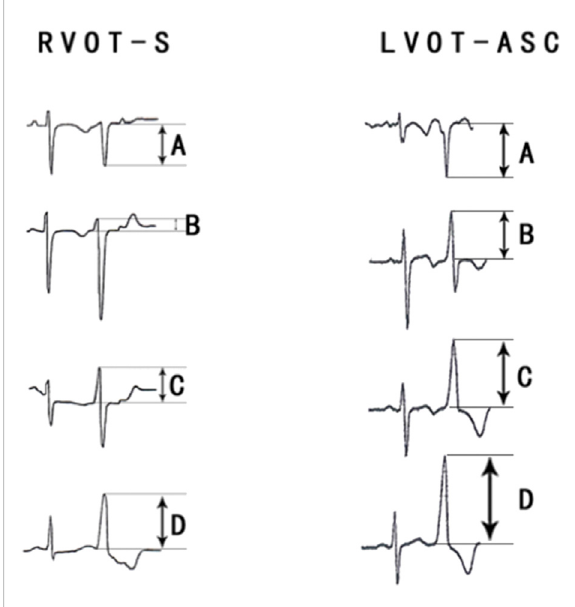
FIGURE 4 (A) ElectrocardiographicmeasurementsoftheR-Sdifference index in precordial leads. (A) S-wave amplitude in lead 1 (mV); (B) R-waveamplitudeinleadV2(mV); (C) R-waveamplitudeinleadV3 (mV); (D) R-wave amplitude in lead V4 (mV); The R-S difference index was calculated with the following formula: B+C+D-A.Fig.4B show the representative images of surface ECGs of both groups.